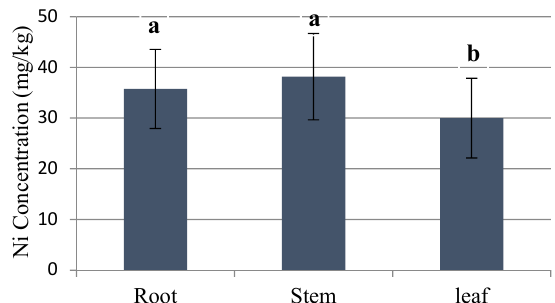
Fig. 2. Mean Ni Concentration in Treatment of 0 mg/kg (control)